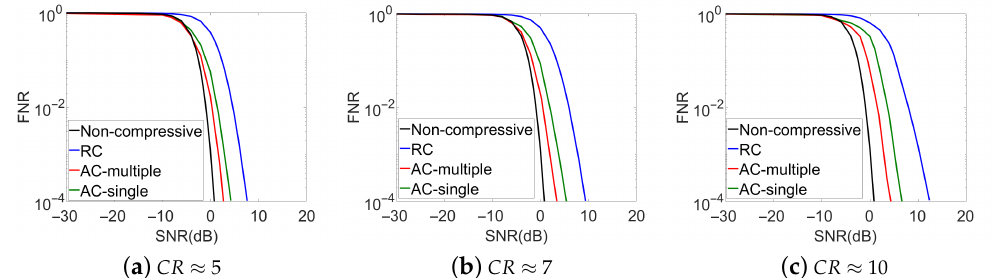
Figure 5. Theoretical Analysis of the Detection Accuracies from Single Symbol-Period Measurements (Non-compressive: Non-compressive detection method; RC: Conventional compressive detection with random measurement kernels; AC-multiple: Adaptive compressive detection with the mul- tiple neural network strategy; AC-single: Adaptive compressive detection with the single neural network